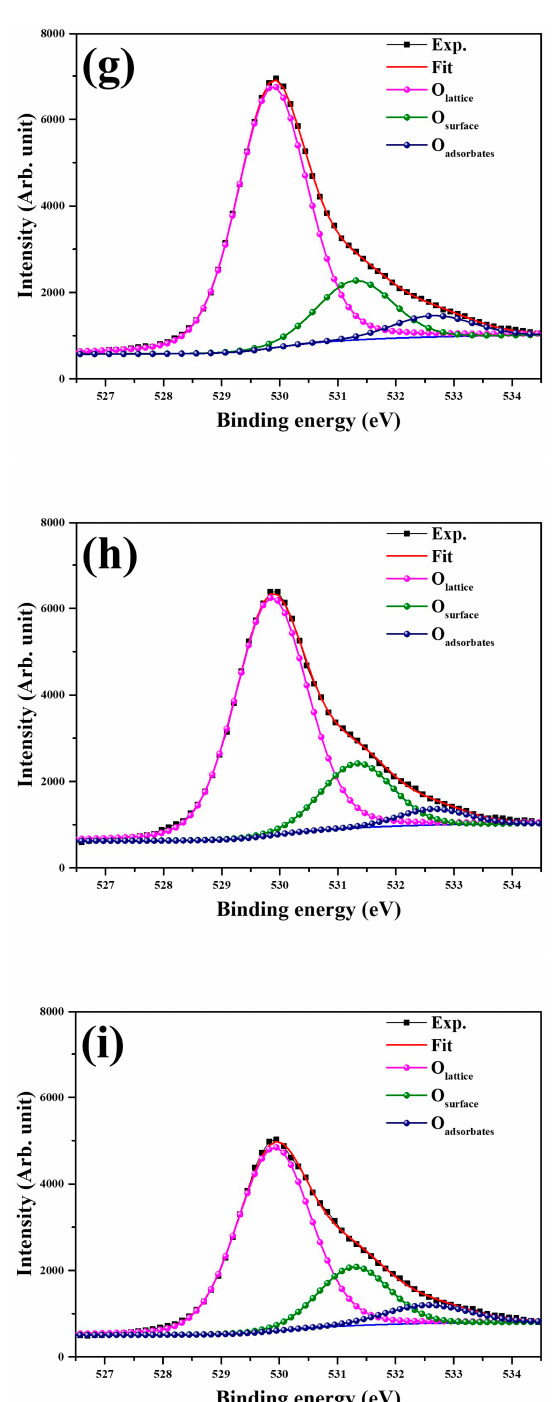
Figure 6. X-ray photoelectron spectroscopy (XPS) spectra of Co 1.2, Co 2.4, and Co 2.7 for Co 2p (( a ), ( b ), and ( c )), Mn 2p (( d ), ( e ), and ( f )) and O 1s (( g ), ( h ), and ( i )) orbitals with fitted lines, respectively. The electrocatalytic activity of mixed materials with Co = 1.2, 2.4, and 2.7 was evaluated using a typical three-electrode system with RDE in a 1 M KOH aqueous solution. Linear sweep voltammetry (LSV) was performed on all samples at a scan rate of 5 mV ∙ s − 1 . All potentials were iR-compensated to the reversible hydrogen electrode (RHE). LSV curves for the oxygen evolution reaction (OER) in 1.0 M KOH are shown in Figure 7a. The overpotential ( η ) required to deliver a current density of 10 mA ∙ cm − 2 ( η 10 ) decreased with increasing Co content and the highest OER activity was observed for